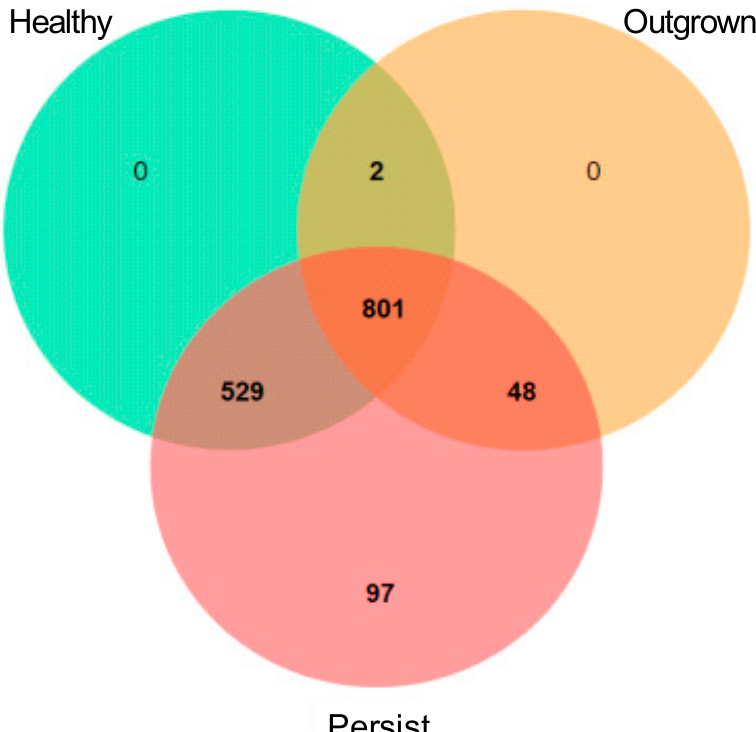
Figure 5. Venn diagram depicting the number of proteins from Rhodotorula sp. in each group of infants. Table 3. Number of proteins from five fungi with more than 50% prevalence level per group. Fungi